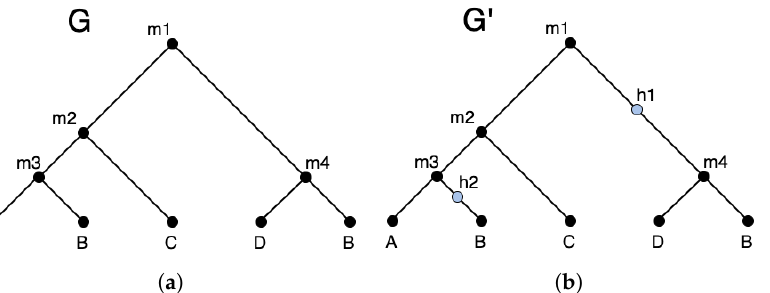
Figure 2. An example gene tree ( a ) and a possible augmented version with hidden nodes in blue ( b